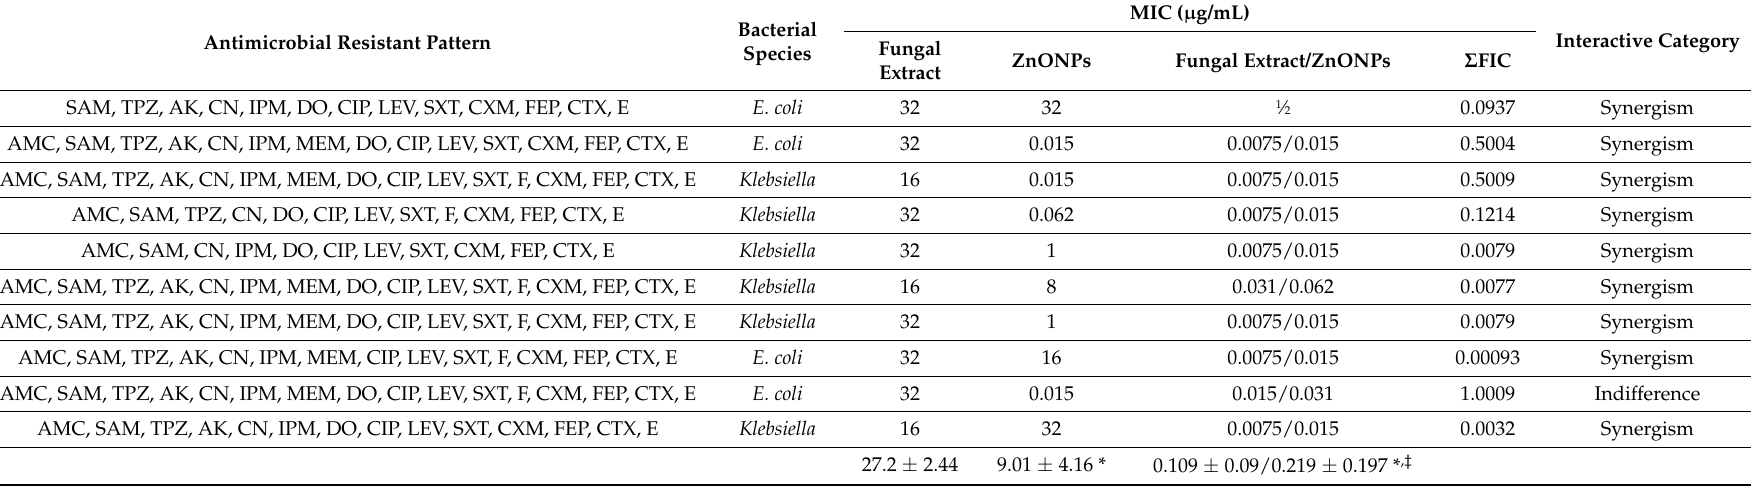
Table 3. MIC results of 6-pentyl- α -pyrone fungal metabolite, zinc oxide nanoparticles, and their combinations against MDR Enterobacterales isolates.